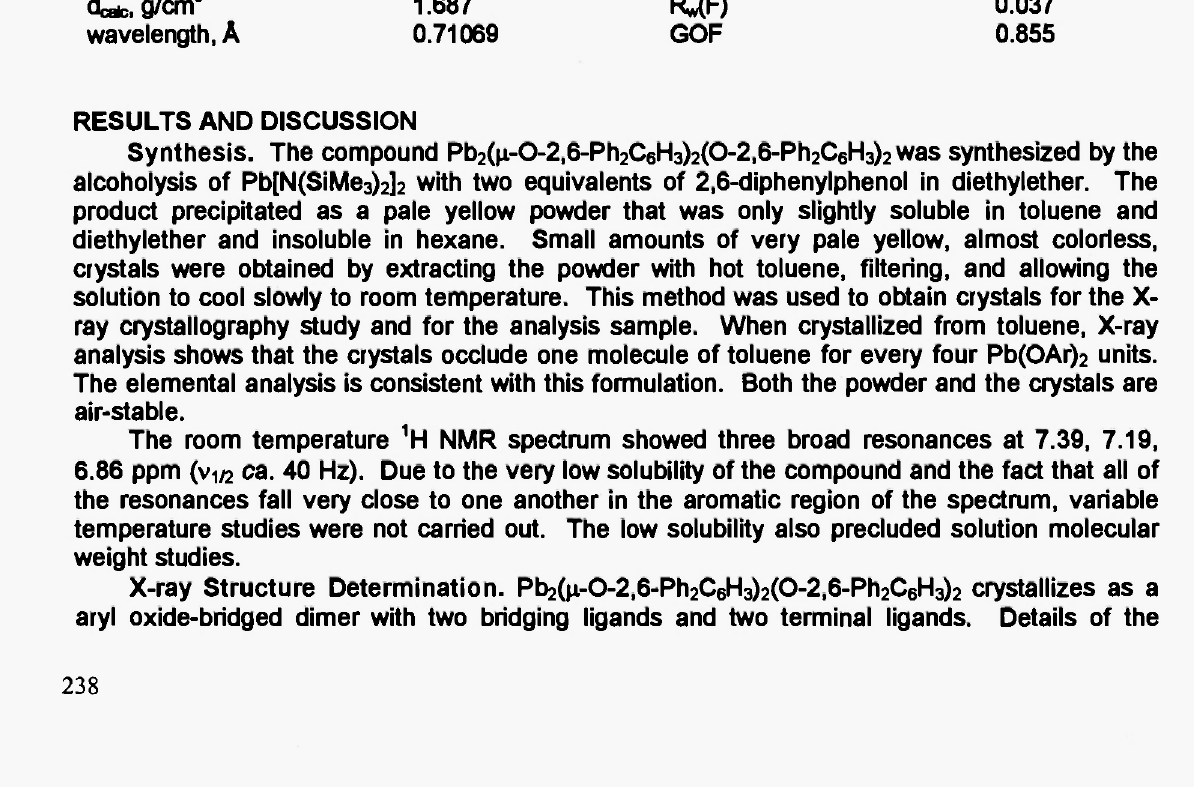
Table I. Crystallographic Data for Ptfrfc-O^.e-PlhCeHsMO^.e-PhzCsHak-I^CyHa chem